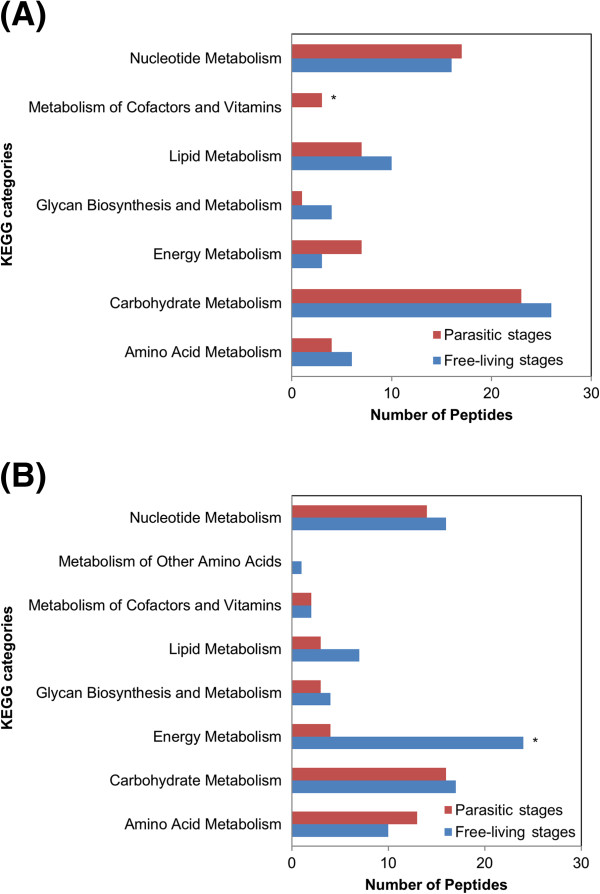
Distribution of KEGG categories associated with up-regulated transcripts. The number of up-regulated transcripts in free-living and parasitic life stages associated with KEGG categories is compared in (A) C. oncophora and (B) O. ostertagi. * indicates significance (p <0.05).